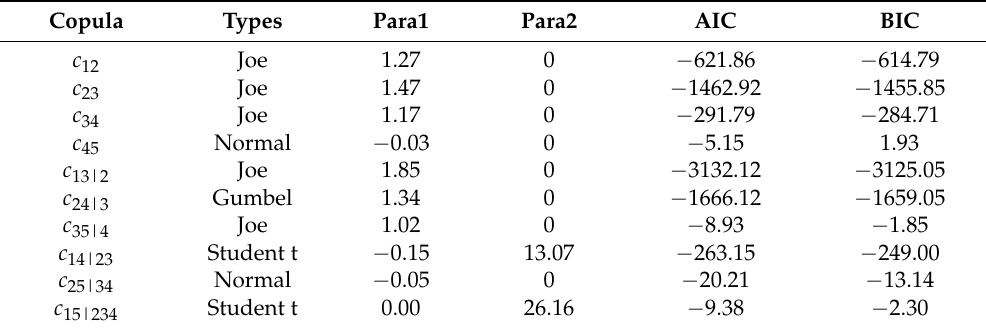
Table 3. Parameters of the constructed D-vine